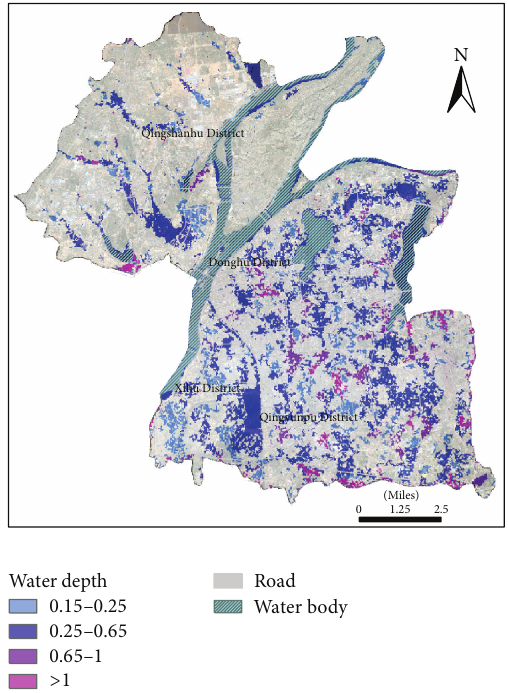
Figure 10: Distribution map of waterlogging in return period of 10 years of Nanchang.